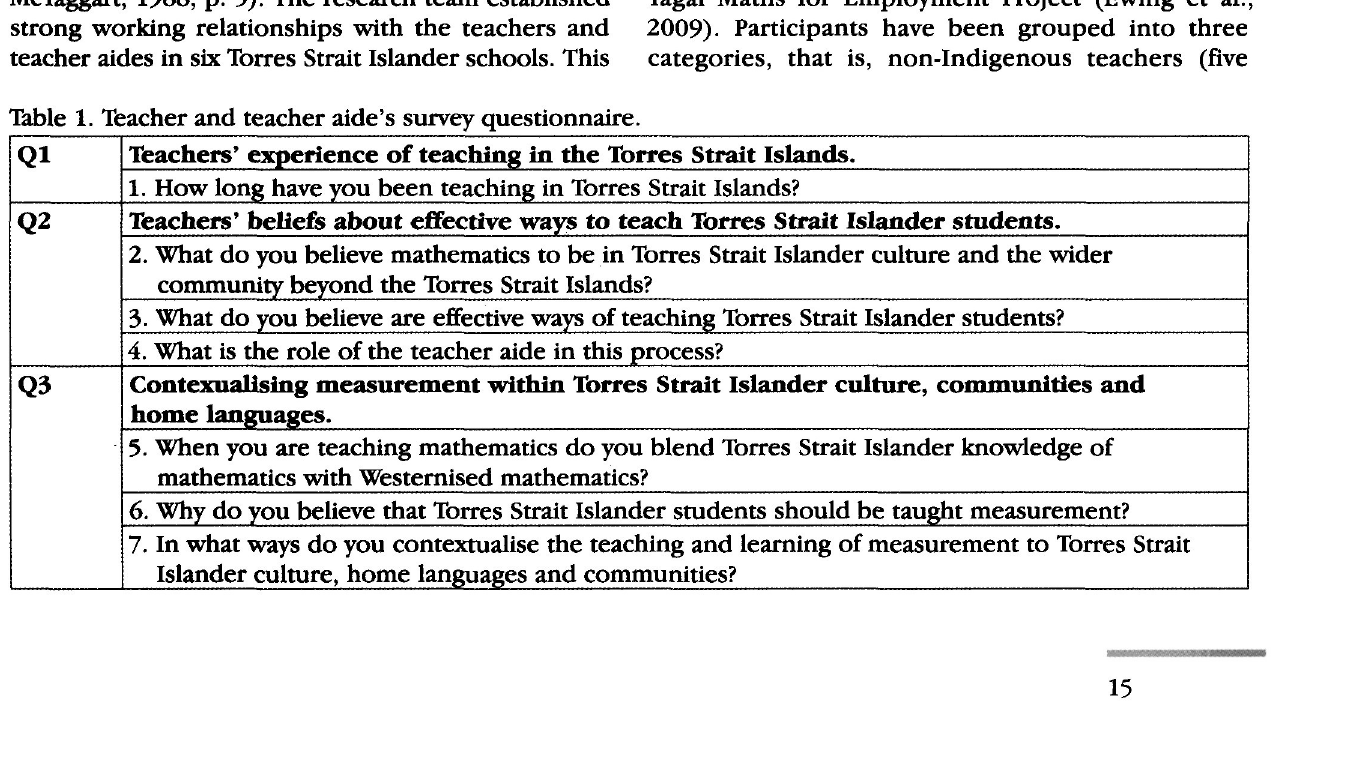
Table 1. Teacher and teacher aide's survey